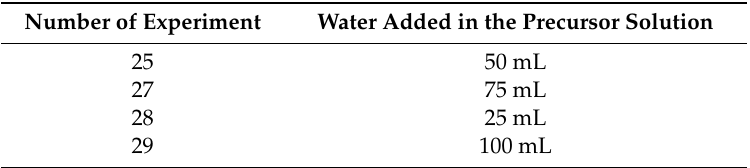
Table 2. The conducted